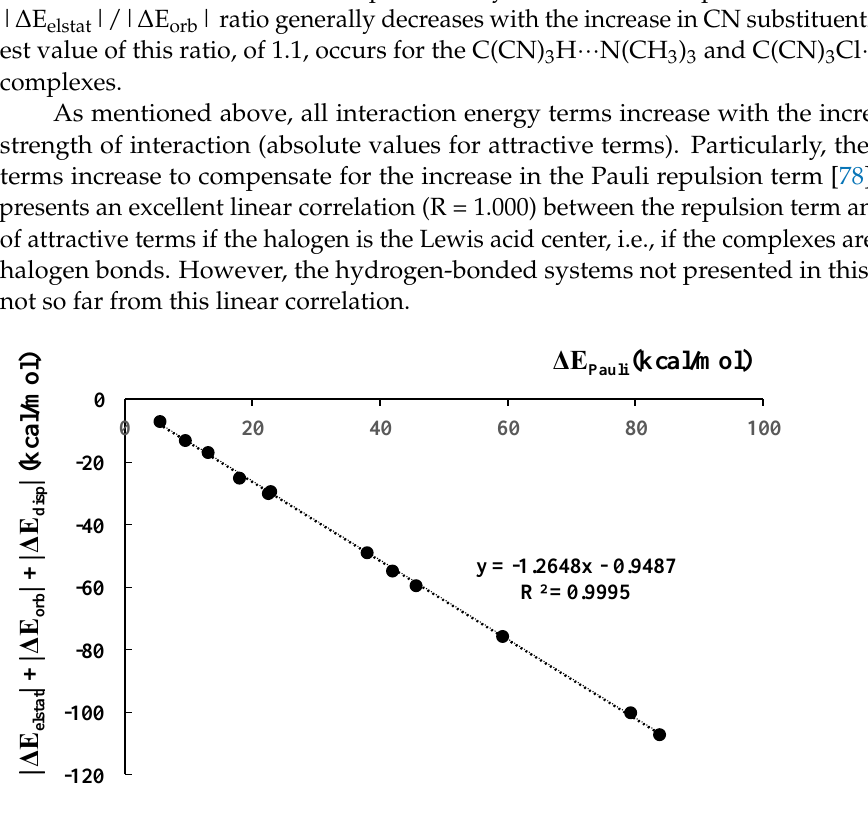
Figure 8. The linear correlation between the Pauli repulsion interaction energy and the sum of all attractive interaction energy terms for halogen-bonded dimers.